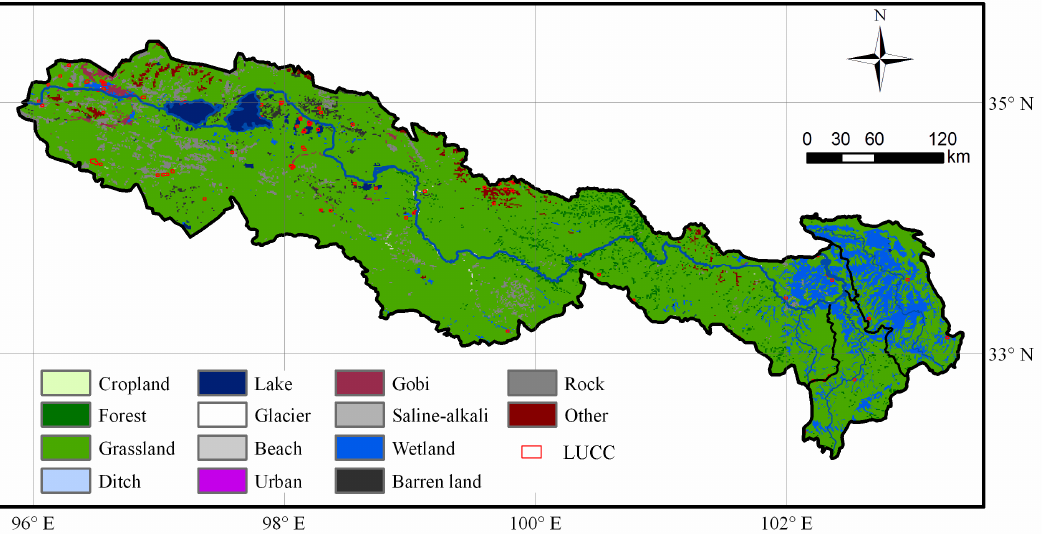
Figure 2. The land cover map of the uYR basin in 1985 derived from a satellite-based Land-use and Land cover Dataset of China [32]. The red polygons indicate areas with land use and cover changes larger than 1 km 2 occurring during the period of 1985–2005.